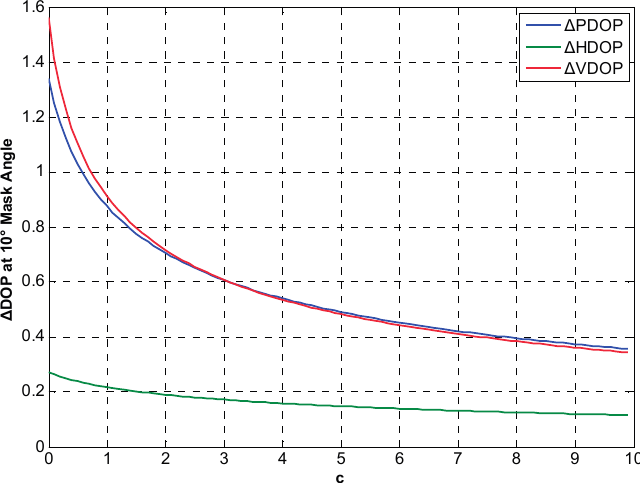
Figure 15. Δ DOP with different c at 10° cutoff angle.